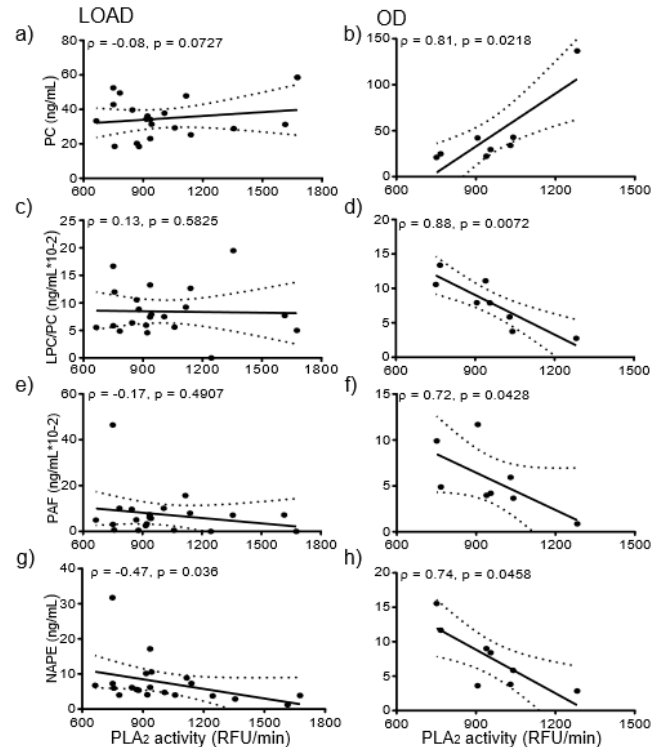
Figure 1. Correlations between PLA 2 activity and GPs- LOAD demonstrated no significant correlation between PLA 2 activity and PC in NP ( a ). However, PLA 2 positively correlated with PC in NP in OD samples ( ρ = 0.81, p < 0.03) ( b ). PLA 2 activity in CSF from LOAD subjects did not correlate with NP LPC / PC ( c ), while PLA 2 activity of OD negatively correlated ( ρ = − 0.88, p < 0.01) with NP LPC / PC ( d ). LOAD PLA 2 activity did not correlate with NP PAF ( e ), while OD PLA 2 activity negatively correlated ( ρ = − 0.74, p < 0.05) with NP PAF ( f ). PLA 2 activity negatively correlated with NAPE in both LOAD ( ρ = − 0.47, p < 0.05) ( g ) and OD ( ρ = − 0.47, p < 0.05) ( h ). PLA 2 activity was available for eight OD because of CSF limitation for two OD